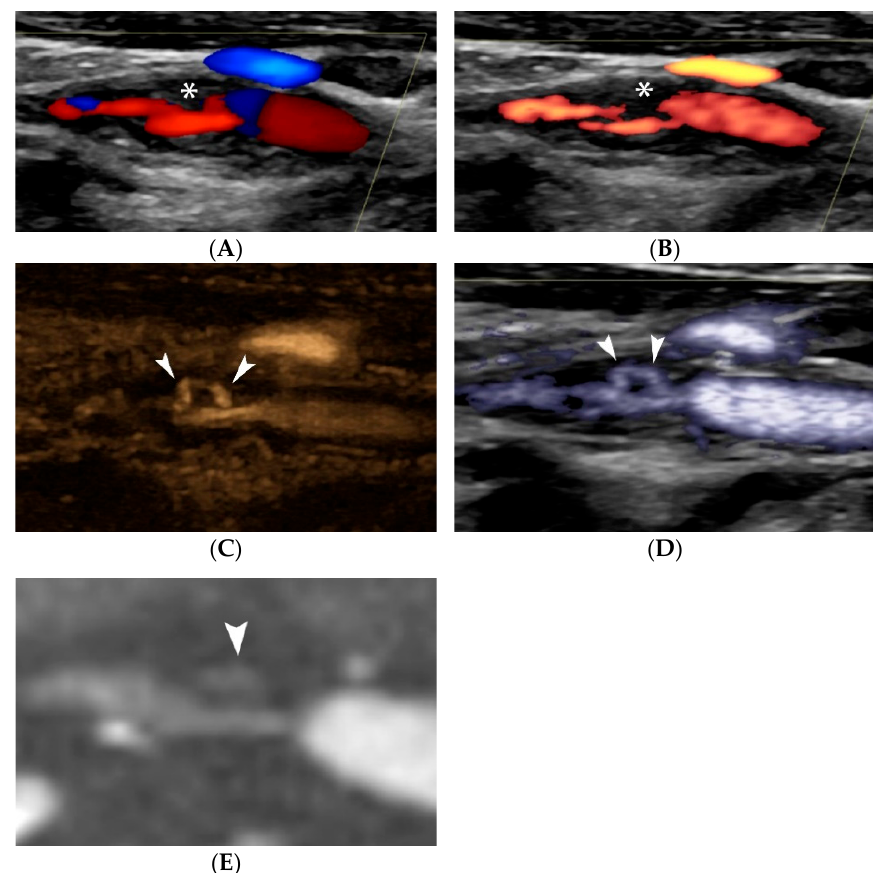
Figure 6. “Handle-shaped” ulceration visualization on Doppler and non-Doppler techniques. Colour Doppler image ( A ) showing a moderately stenotic internal carotid artery plaque with irregular surface (asterisk). Power Doppler technique ( B ) confirming the findings but visualizing more pronounced irregularity (asterisk). B-Flow technique with ( C ) and without static tissue suppression ( D ) show that there is actually a tunnel-like ulceration (arrowheads), also partially identified on CTA ( E ) as an area of enhancement (arrowhead) inside the plaque. Note the blurred appearance of ulceration on CTA due to the lower spatial resolution of the technique as compared with ultrasound, which offers excellent spatial resolution in the field-of-view, particular in the near field. Carotid plaque ulceration has been long considered a major risk factor for stroke [45,46]. Carotid plaques with different ulcer depths have been correlated with embolic signals on transcranial Doppler US regardless of the degree of stenosis [47,48]. In a study where patients with symptomatic low-grade (<50%) carotid stenosis underwent endarter-